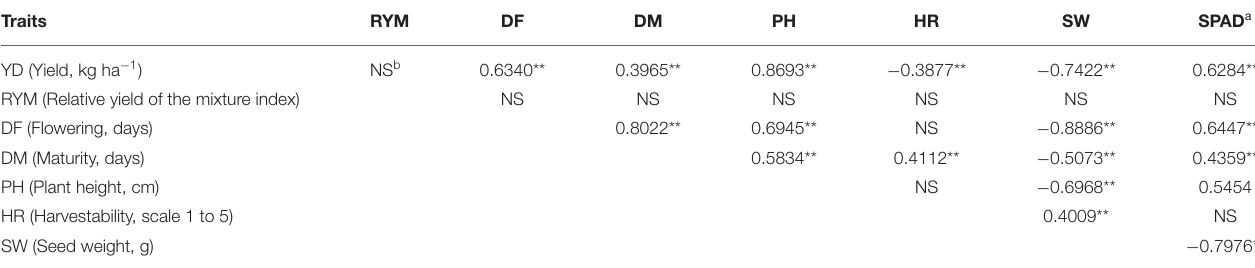
TABLE 2 | Correlations among analyzed traits averaged over three Ontario environments in 2018 (LSmeans, N = 49). Traits RYM DF DM PH HR